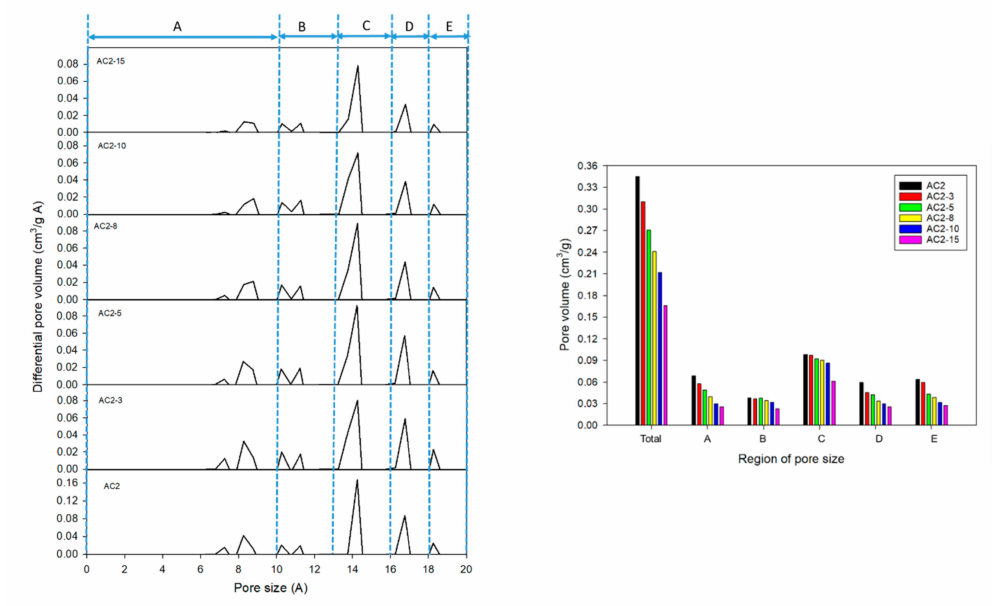
Figure 6. Effect of NaOH loading on the pore size distribution and local pore volume of NaOH impregnated activated carbons AC2, computed by the GCMC simulation using N 2 as a probe